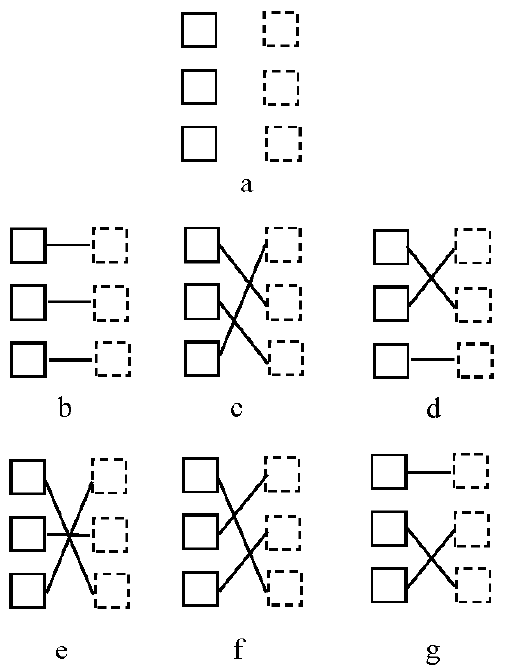
Figure 1. ( a ) An example of an apparent motion display. Outline squares represent element positions in Frame 1; dashed squares represent element positions in Frame 2. ( b – g ) Possible motion correspondence solutions for display ( a ): solid lines indicate the assigned motion correspondence matches. Solution ( b ) is the one generated by the human visual system. Adapted from [5].